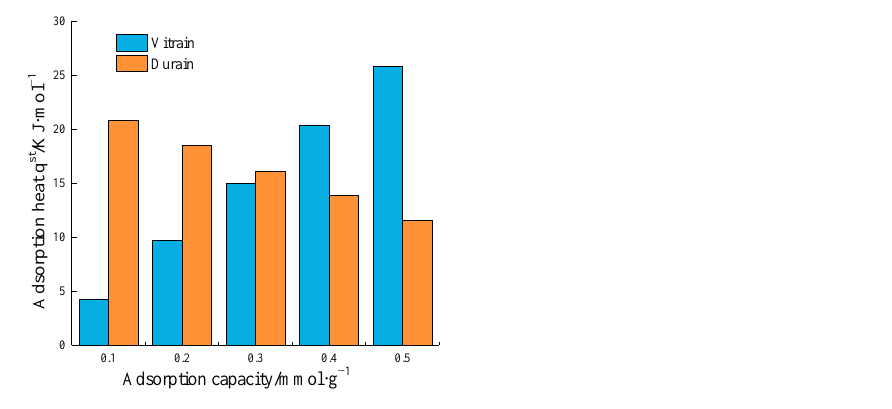
Table 12. Fitting of adsorption characteristic parameters of different wettability coal samples.